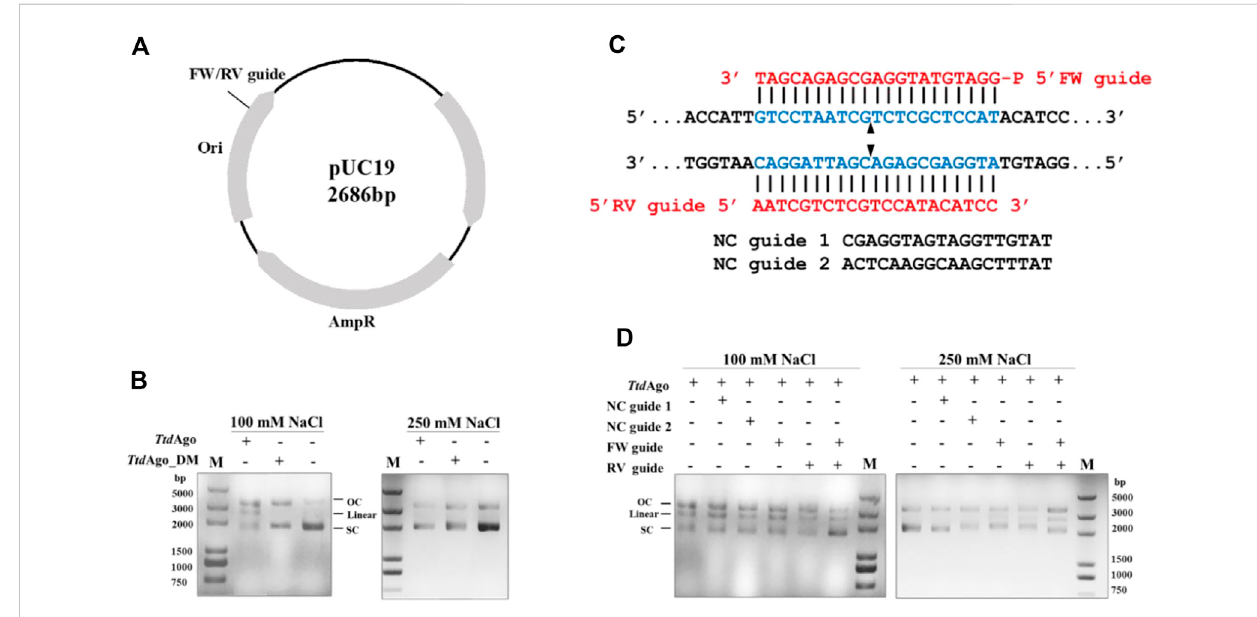
FIGURE 6 Double-stranded plasmid DNA cleavage assay by Ttd Ago. (A) Schematic overview of pUC19 plasmid. Black polylines indicate target sites. (B) Cleavage assay of Ttd Ago in the absence of guides under different concentrations of NaCl. (C) Schematic of sequences of the 5 ′ -phosphorylated DNA guides and target plasmid region. The blue region indicates the target region. The red region indicates the sequences of FW or RV guides. Predicted cleavage sites are indicated with a black triangle. (D) Plasmid cleavage assay was performed by loading Ttd Ago in the reaction buffer containing 10 mM Mg 2+ with the indicated 5 ′ -P-gDNAs at 37 ° C for 10 min, followed by incubation with the target plasmid at 75 ° C for 20 min. The analysis of the target plasmid was performed by electrophoresis. M, 5,000 bp DNA ladder; linear, linearized plasmid; SC, supercoiled plasmid; OC, open-circular